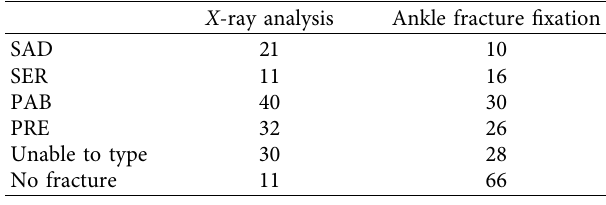
Table 2: Lauge–Hansen classification of ankle fractures in sports.